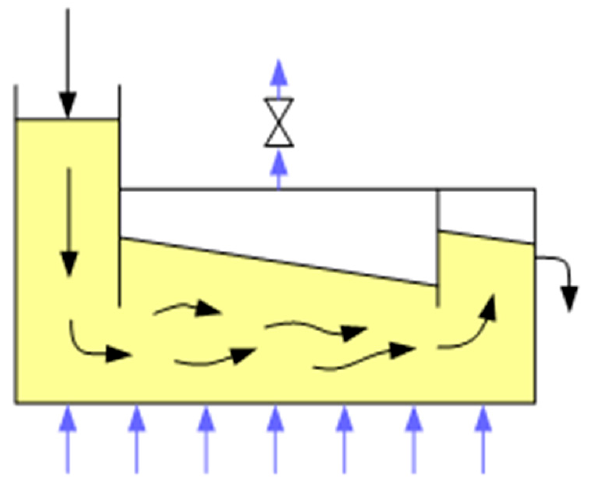
Figure 1. Sketch of the sandTES fluidized bed heat exchanger. Black arrows represent the flow of sand (yellow), while blue arrows show the fluidization air flow. The valve at the top is used to create a pressure zone (so-called air cushion) to control the sand level below. Both sand and fluidization gas are external flows.